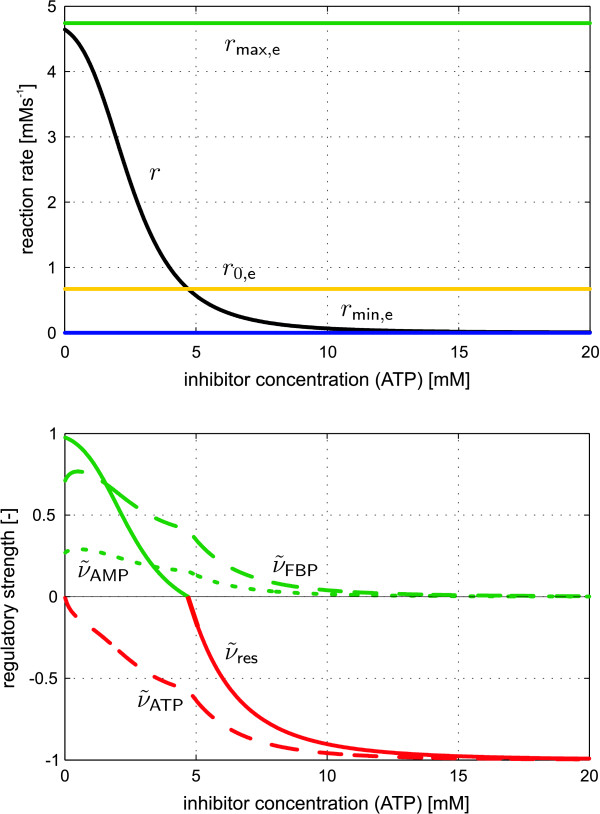
RS determination of the Pk reaction. The time courses of simulated reaction rates for the Pk reaction (top) are the basis for the determination of the resulting RS (νres) as well as for single RS values ν˜ATP
 MathType@MTEF@5@5@+=feaafiart1ev1aaatCvAUfKttLearuWrP9MDH5MBPbIqV92AaeXatLxBI9gBaebbnrfifHhDYfgasaacH8akY=wiFfYdH8Gipec8Eeeu0xXdbba9frFj0=OqFfea0dXdd9vqai=hGuQ8kuc9pgc9s8qqaq=dirpe0xb9q8qiLsFr0=vr0=vr0dc8meaabaqaciaacaGaaeqabaqabeGadaaakeaaiiGacuWF9oGBgaacamaaBaaaleaacqqGbbqqcqqGubavcqqGqbauaeqaaaaa@3205@, ν˜FBP
 MathType@MTEF@5@5@+=feaafiart1ev1aaatCvAUfKttLearuWrP9MDH5MBPbIqV92AaeXatLxBI9gBaebbnrfifHhDYfgasaacH8akY=wiFfYdH8Gipec8Eeeu0xXdbba9frFj0=OqFfea0dXdd9vqai=hGuQ8kuc9pgc9s8qqaq=dirpe0xb9q8qiLsFr0=vr0=vr0dc8meaabaqaciaacaGaaeqabaqabeGadaaakeaaiiGacuWF9oGBgaacamaaBaaaleaacqqGgbGrcqqGcbGqcqqGqbauaeqaaaaa@31EB@, ν˜AMP
 MathType@MTEF@5@5@+=feaafiart1ev1aaatCvAUfKttLearuWrP9MDH5MBPbIqV92AaeXatLxBI9gBaebbnrfifHhDYfgasaacH8akY=wiFfYdH8Gipec8Eeeu0xXdbba9frFj0=OqFfea0dXdd9vqai=hGuQ8kuc9pgc9s8qqaq=dirpe0xb9q8qiLsFr0=vr0=vr0dc8meaabaqaciaacaGaaeqabaqabeGadaaakeaaiiGacuWF9oGBgaacamaaBaaaleaacqqGbbqqcqqGnbqtcqqGqbauaeqaaaaa@31F7@ of the inhibitor ATP and the two activators FBP and AMP, respectively (bottom). Kinetic parameters: ATPmax = FBPmax = AMPmax = 108; PEP = 0.8; ADP = FBP = 0.5; AMP = 0.1; rmax = 10; KPEP = 0.31; KADP = 0.26; KATP = 1.5; KFBP = 0.19; KAMP = 0.2; L = 1000; n = 4.